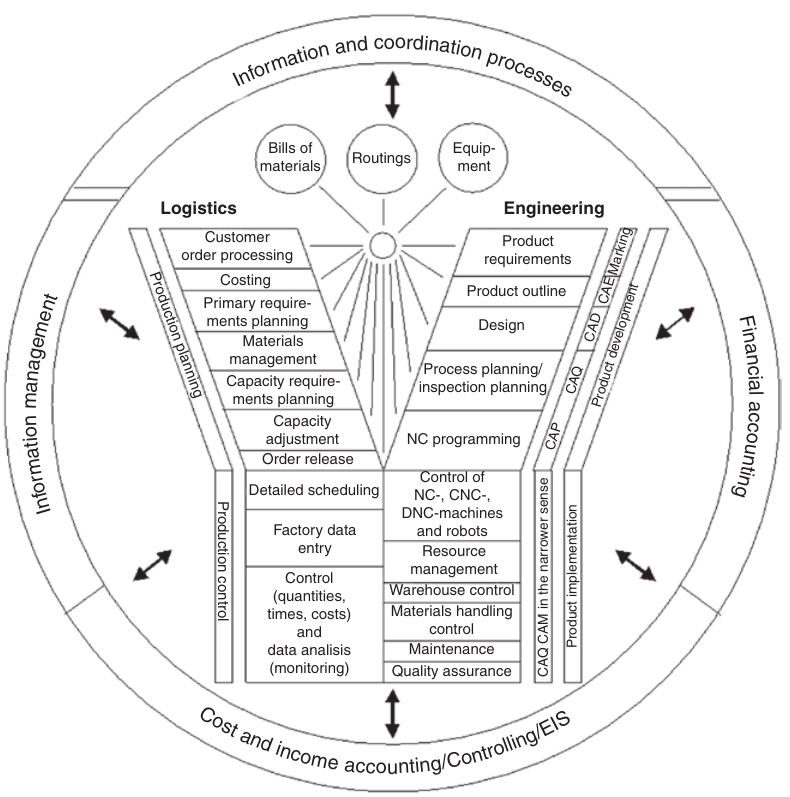
Figure 6: General Scheme of the Y-CIM